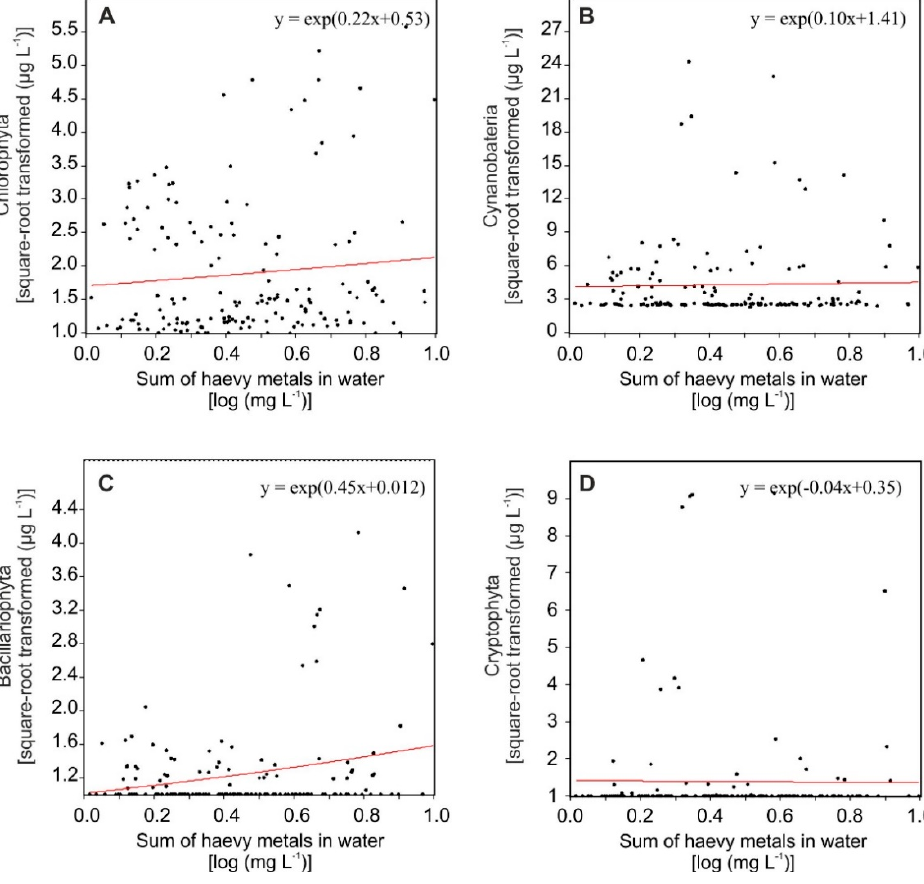
Figure 2. Generalized linear model for phytoplankton group metrics as response variables, and the sum of heavy metals as an explanatory variable, with the link function (log) based on chlorophyll-a concentration, as a measure of the biomass of the Chlorophyta ( A ), Cyanobacteria ( B ), Bacillariophyta ( C ), and Cryptophyta ( D ).